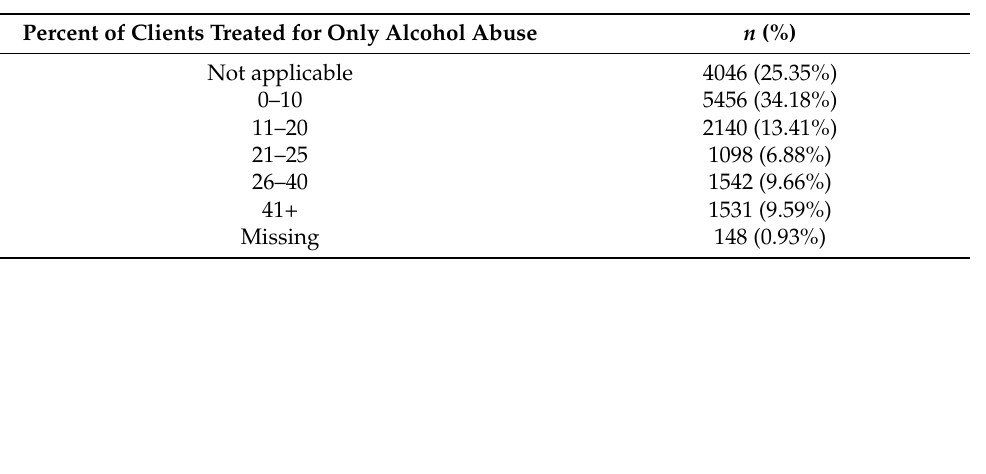
Table 1. Distribution of substance use treatment facilities in 2019 by the percentage of clients treated for only alcohol abuse using N-SSATS